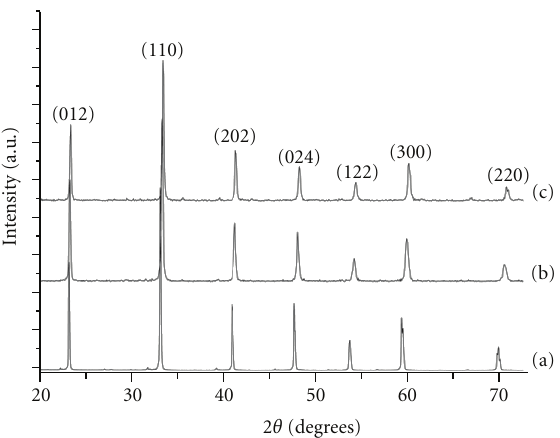
Figure 3: XRD patterns of (a) LaAlO 3 , (b) La 0 . 3 Eu 0 . 7 AlO 3 , and (c) La 0 . 1 Eu 0 . 9 AlO 3 . Perovskite-like structure is maintained although a small change in cell parameter a is observed. Peaks are indexed with PDF card number 031-0022.